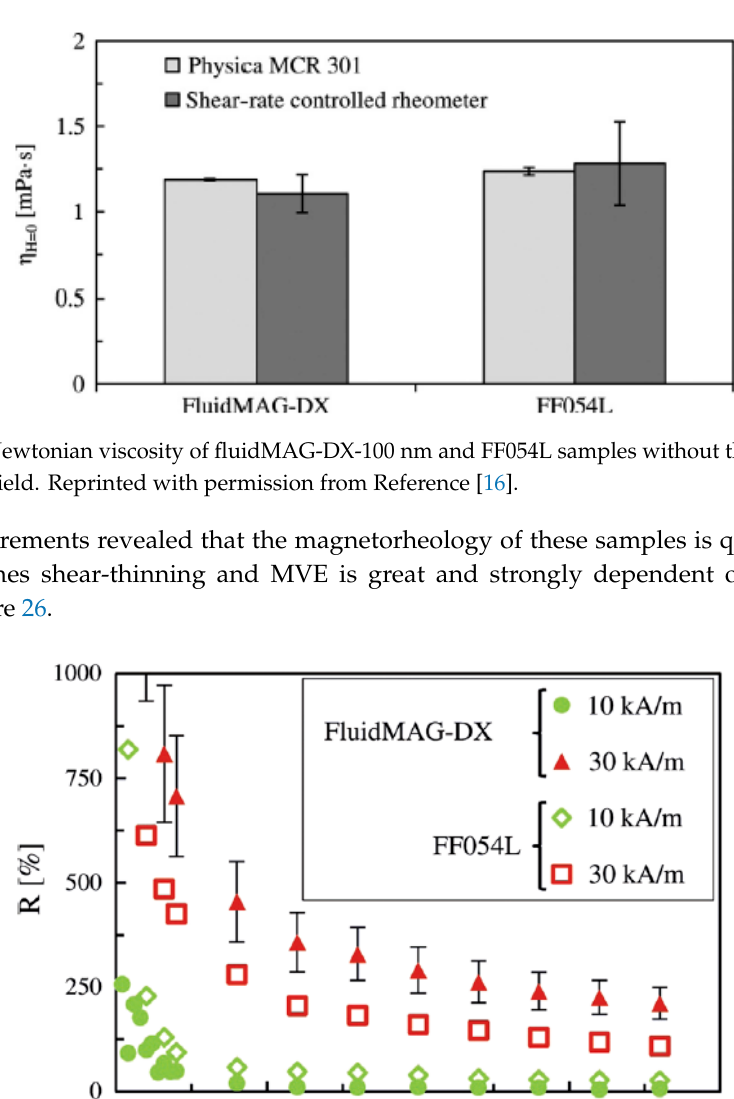
26 of 36 Figure 24. The MVE of the ferrofluid fluidMAG-D-200 nm for three magnetic field strengths depending on the shear rate. Reprinted with permission from Reference [164]. Nowak et al. [167] have comparatively investigated a dilution series starting from two bio- ferrofluids to determine direct connections between the microscopic make-up and the actual